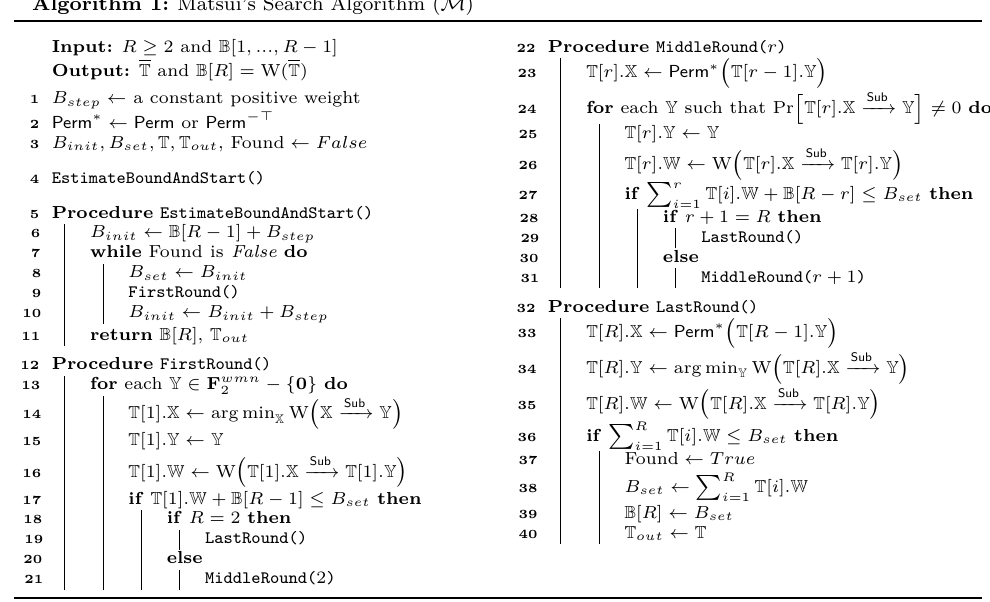
Algorithm 1: Matsui’s Search Algorithm ( M